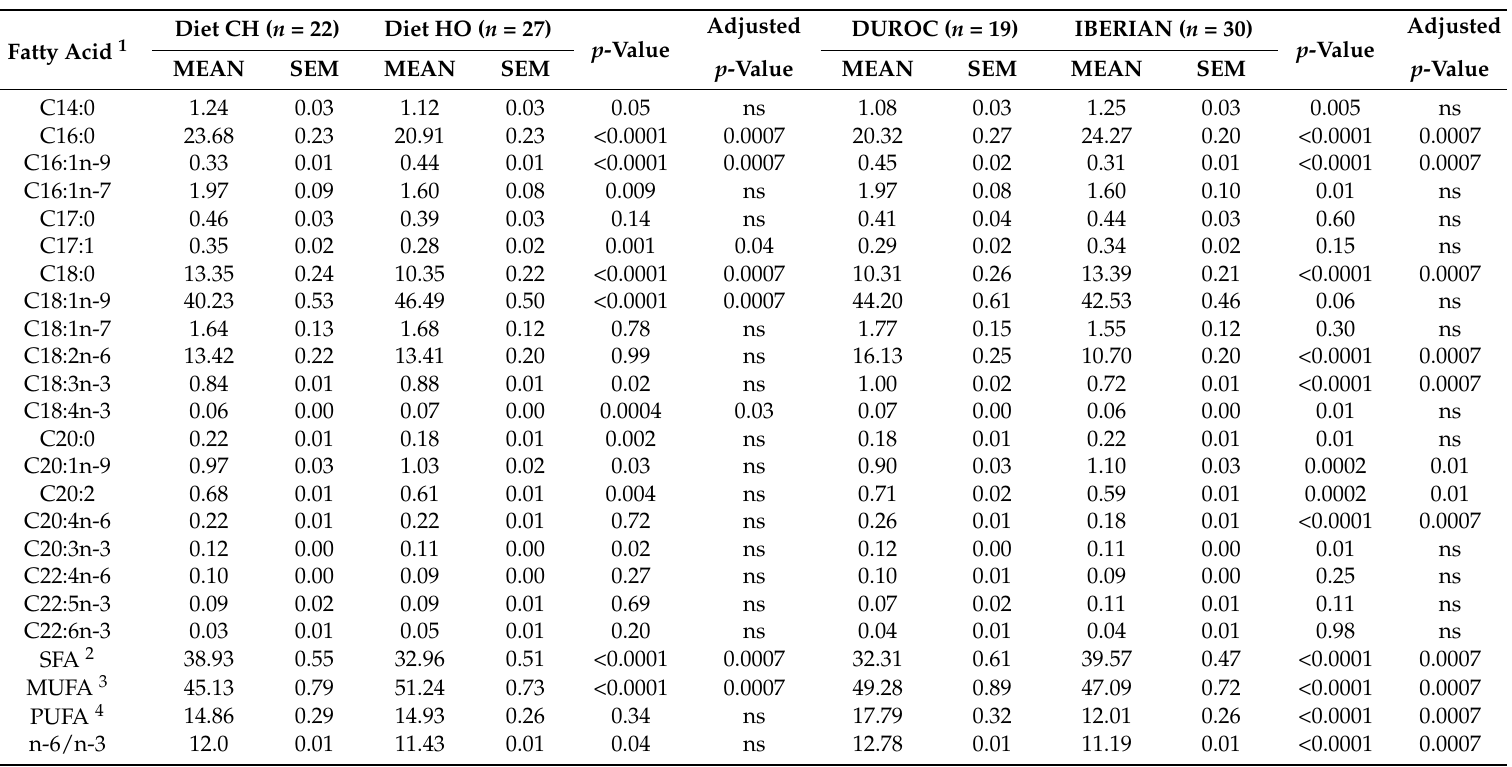
Table 1. Least-squares means and standard errors (SEM) of fatty acid percentages in subcutaneous backfat (inner layer) from Iberian and Duroc pigs fed with a diet enriched with high-oleic sunflower oil (HO) or a standard diet with carbohydrates as energy source